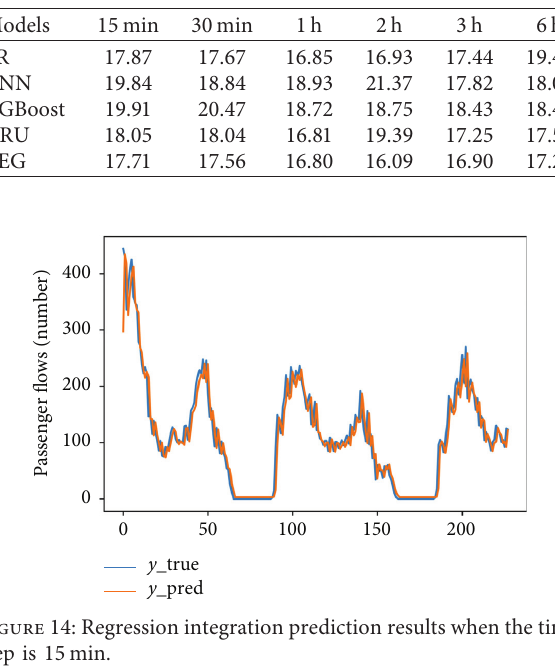
Table 4: Multimodel RMSE comparison table for different step sizes.